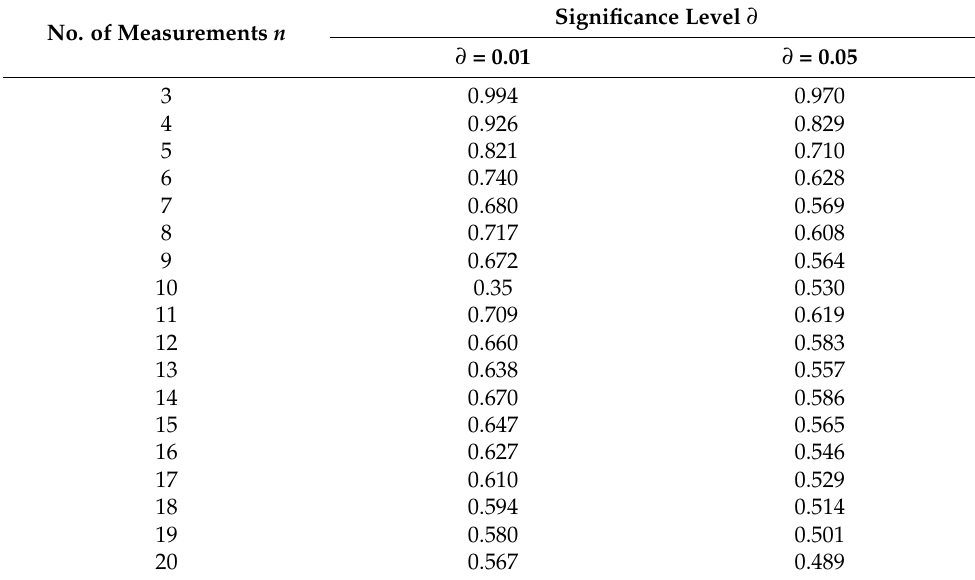
Table 4. Dixon threshold